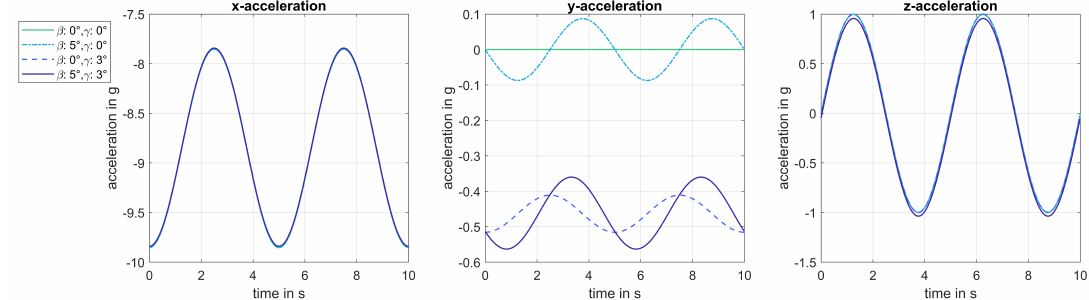
Figure 4. Simulation of the measured acceleration for varying mounting positions with β ∈ { 0°,3°,5° } , γ ∈ { 0°,3°,5° } and R = 55m: steady movement and no wind effects were